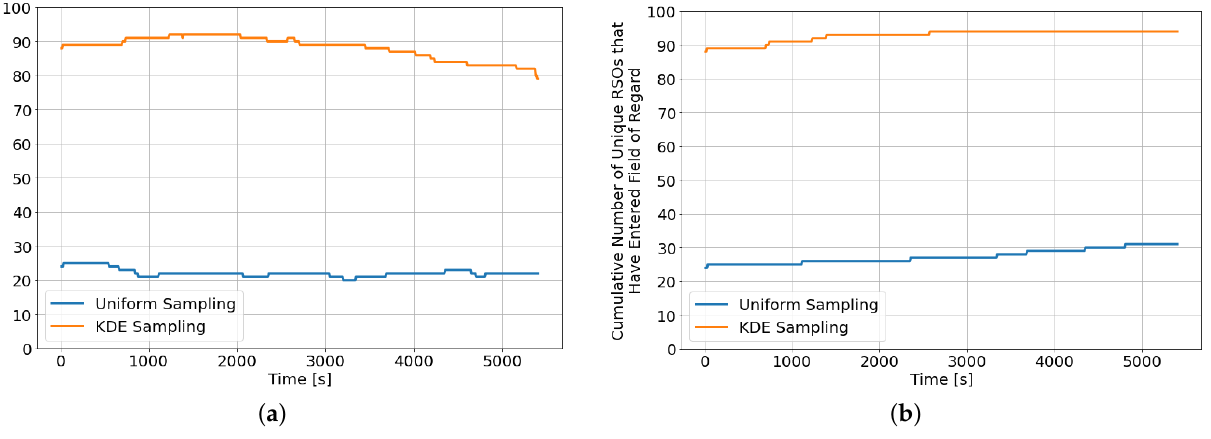
Figure 2. Comparisons between KDE sampling and uniform sampling over a single rollout of 90 min. ( a ) Number of RSOs in field of regard; ( b ) Cumulative number of unique RSOs in field of regard since the beginning of the episode.